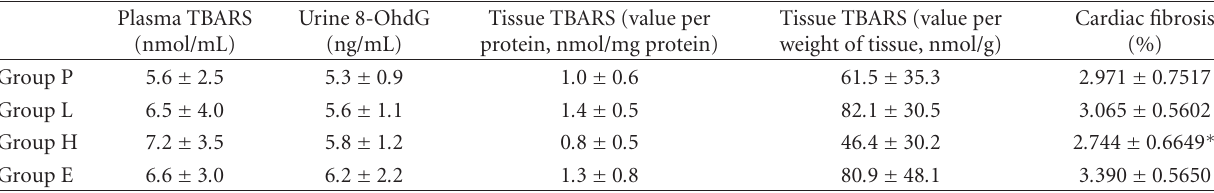
Mean ± SD, ∗ means significant decrease compared with Group E.